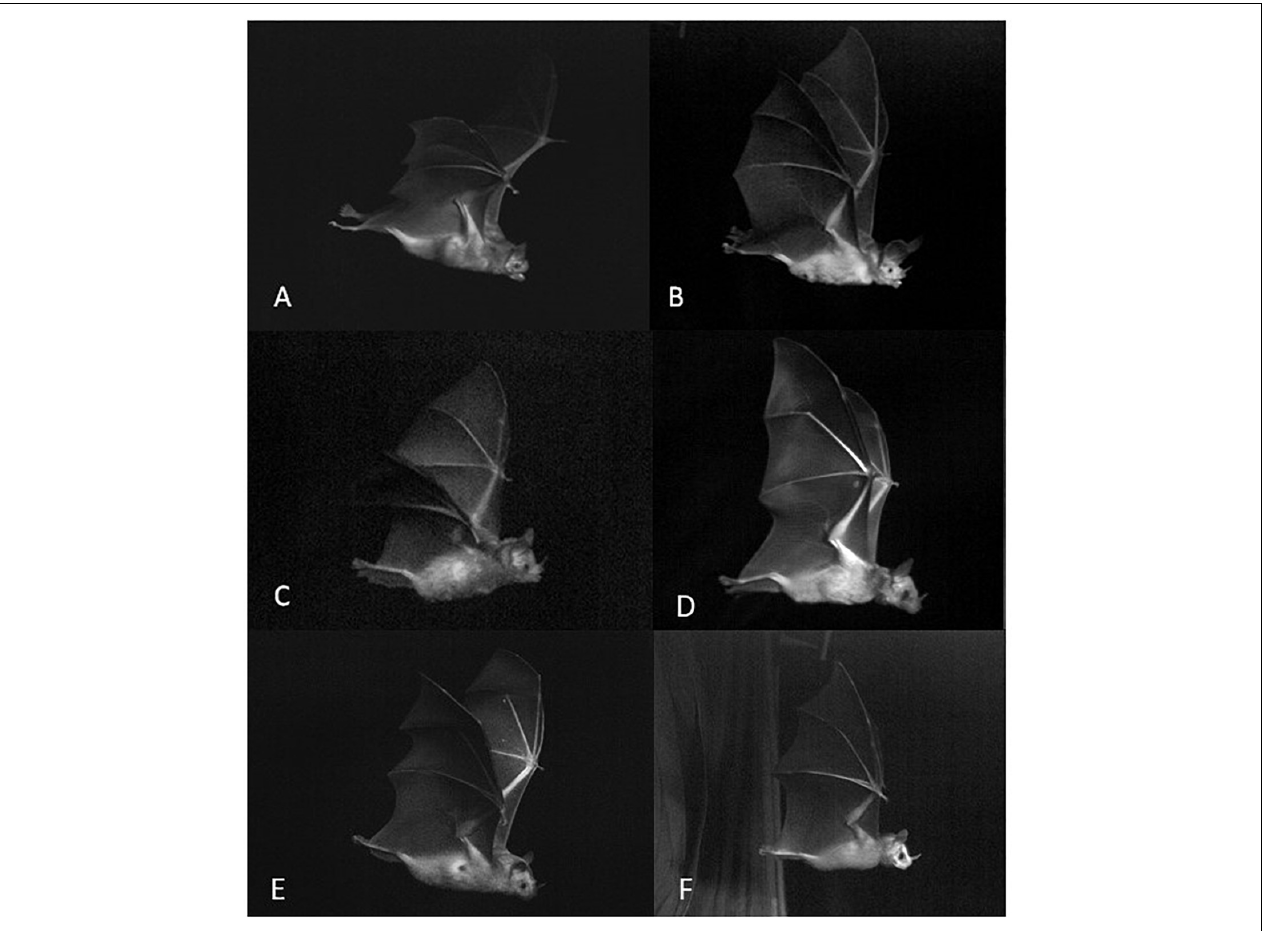
FIGURE 2 | Examples of still shots extracted from the high-speed videos. Open-mouth phyllostomids (gape angle > 0 ◦ ): (A) Desmodus rotundus , (B) Lophostoma silvicolum , (C) Carollia castanea . Nasal emitters: (D) Phyllostomus discolor , (E) Artibeus jamaicensis , (F) Vampyrodes major .